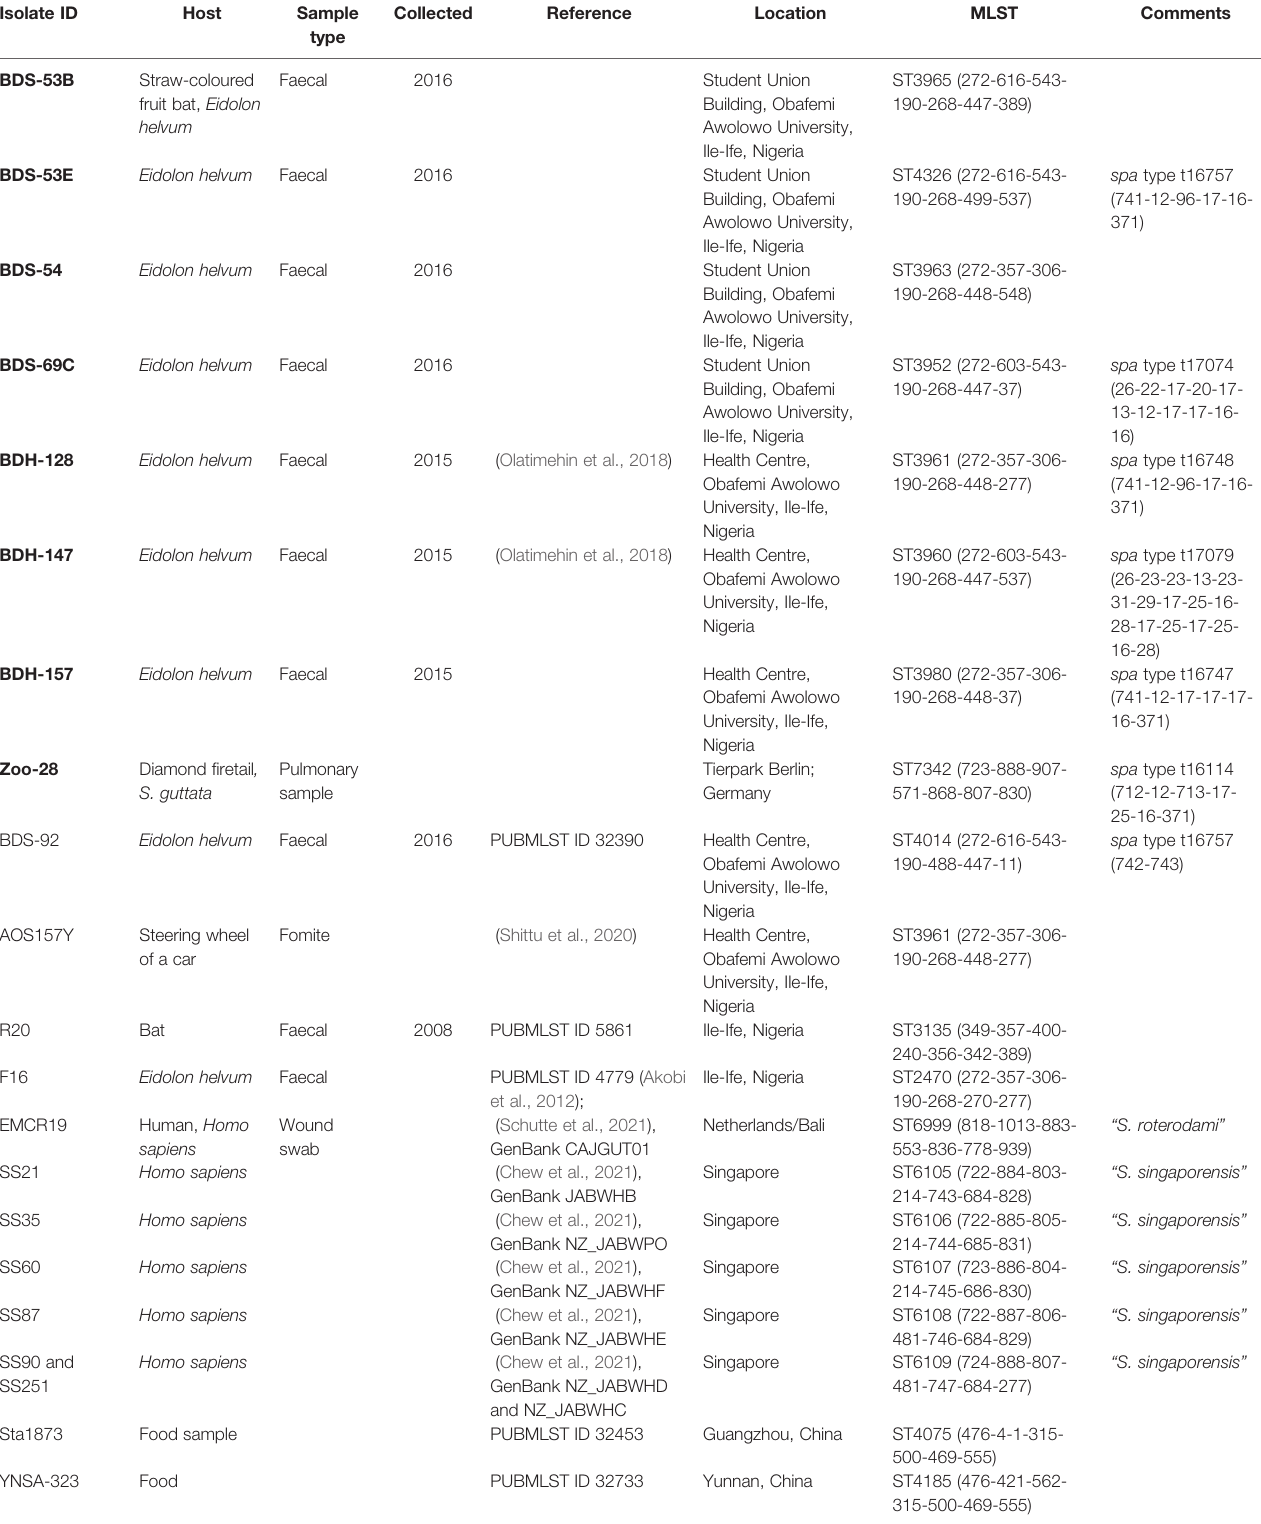
TABLE 1 | Details of animals and isolates described herein (bold font), as well as of related isolates described otherwise or listed in the MLST